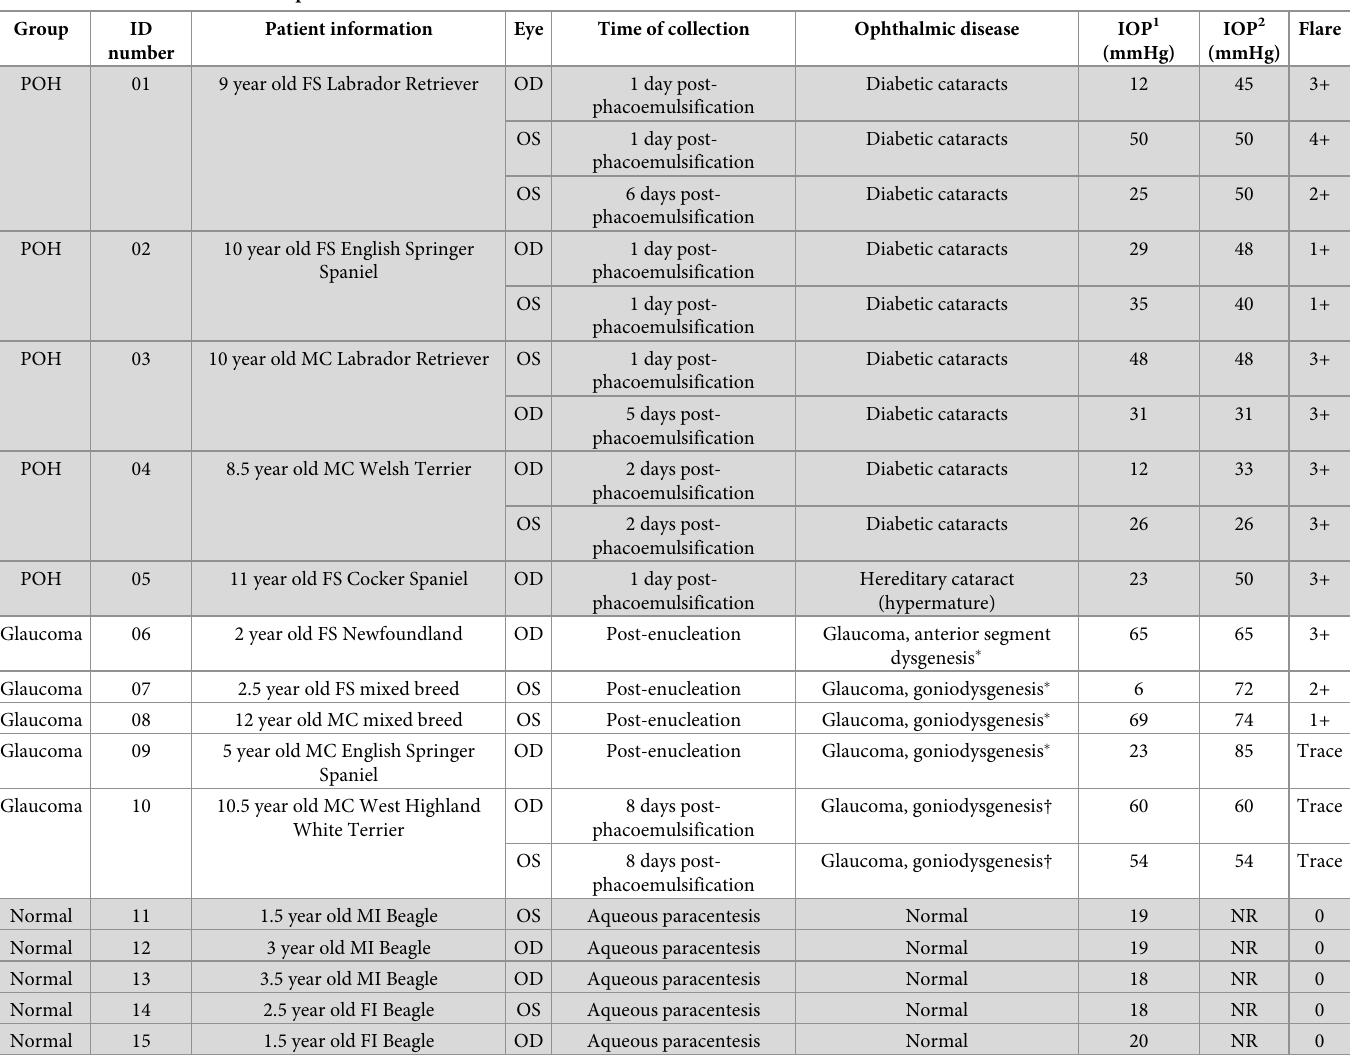
Table 1. Clinical information of all